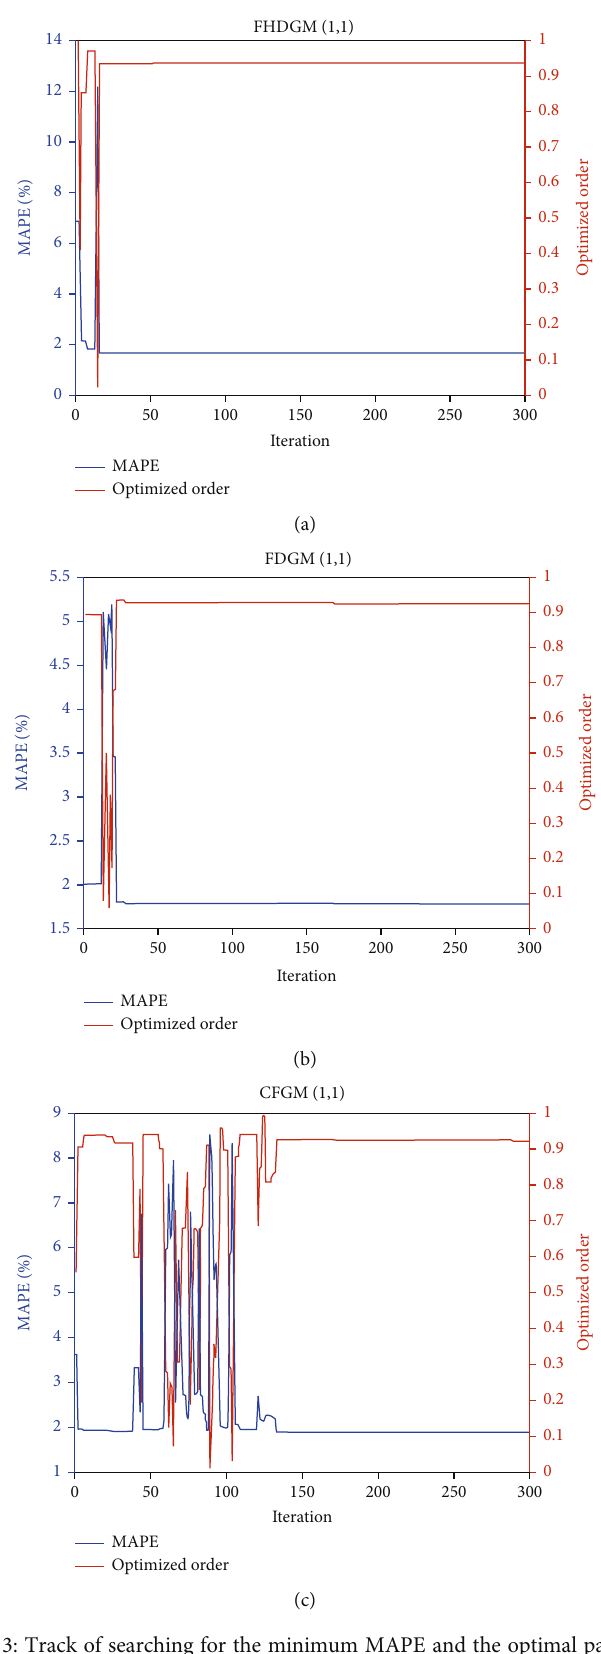
Figure 3: Track of searching for the minimum MAPE and the optimal